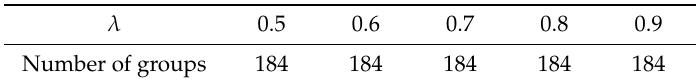
Table 1. The relationship between λ and the number of groups (corn data).